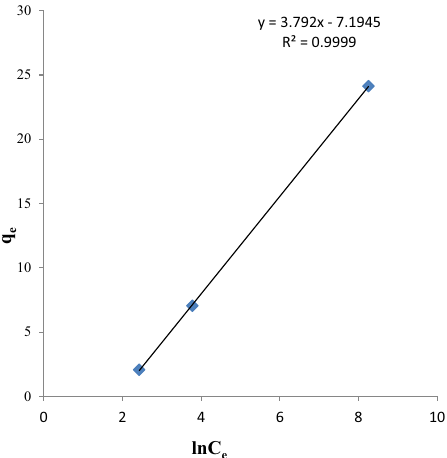
Fig. 5 Langmuir adsorption isotherm of Fe + 3 in case of A. niger as biomass. The isotherm was measured for initial values of iron (III) Fig. 7 Temkin adsorption isotherm of Fe + 3 in case of A. niger as between 2.052 and 4811.98 mg/L, at room temperature, at optimum biomass. The isotherm was measured for initial values of iron (III) condition for the best adsorption (pH = 2.4, time of adsorption between 2.052 and 4811.98 mg/L, at room temperature, at optimum 60 min and for 4 g biomass). condition for the best adsorption (pH = 2.4, time of adsorption 60 min and for 4 g y = 0.3843x + 0.0448